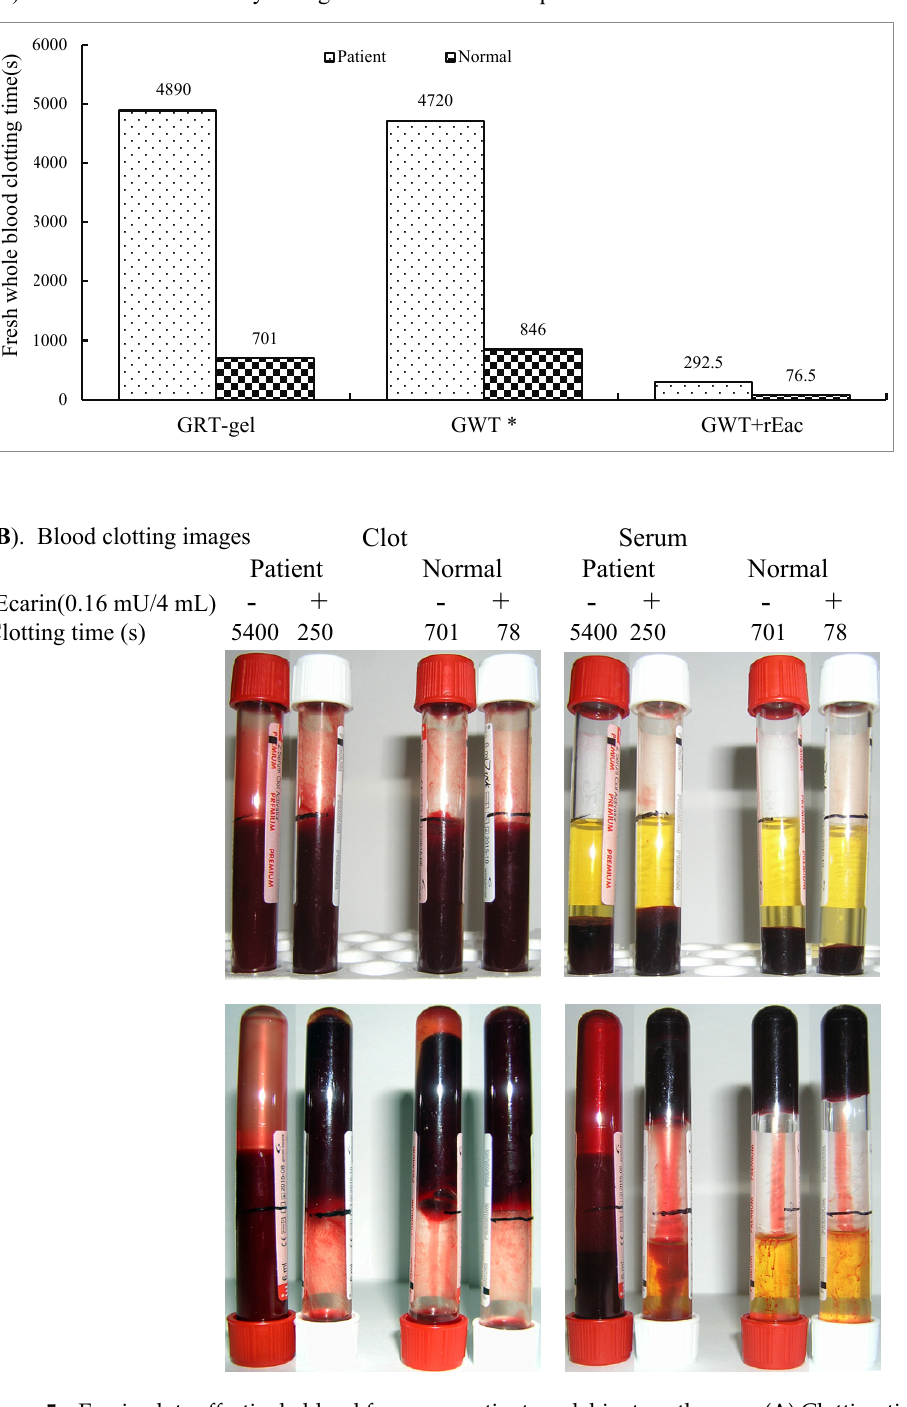
Figure 5. rEcarin clots effectively blood from one patient on dabigatran therapy. ( A ) Clotting time of the dabigatran-containing whole fresh blood sample from a patient volunteer who was treated with dabigatran with 0.16 mU rEcarin in 4 mL blood, compared with that of normal blood. Data are the mean ± standard deviation (SD) of two time points ( n = 4). GRT = Commercial GBO red top blood collection tube; GWT = Commercial GBO white top blood collection tube; GWT+ rEcarin = Commercial GBO white top blood collection tube + 0.16 mU rEcarin for 4 mL of blood in clotting assay. ( B ) Clotting images of one Dabigatran-containing blood sample from a patient volunteer who was treated with dabigatran with or without 0.16 mU rEcarin in 4 mL of blood, compared with that of normal blood at the first time point